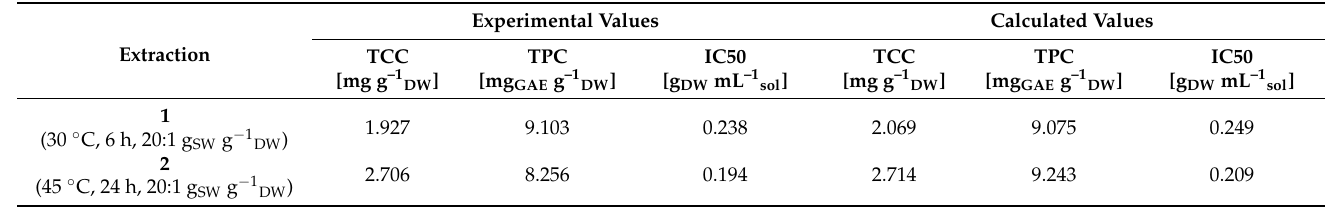
Table 5. Experimental conditions of the extractions conducted for models’ validation and the corre- sponding experimental and calculated TCC, TPC, and IC50 values.